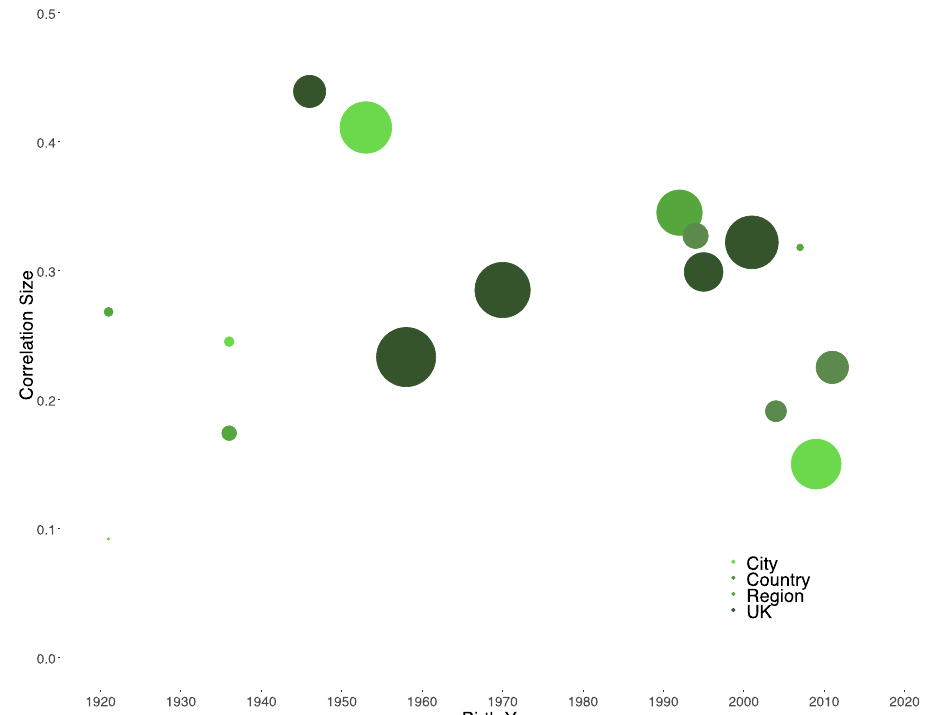
Fig. 1 Raw correlations between family SES and children ’ s school performance across 16 cohorts born from 1921 through 2011. Note: The circles ’ size represents the respective cohort ’ s sample size; the circles ’ colors re fl ect the cohorts ’ geographical scope. Pearson correlations were